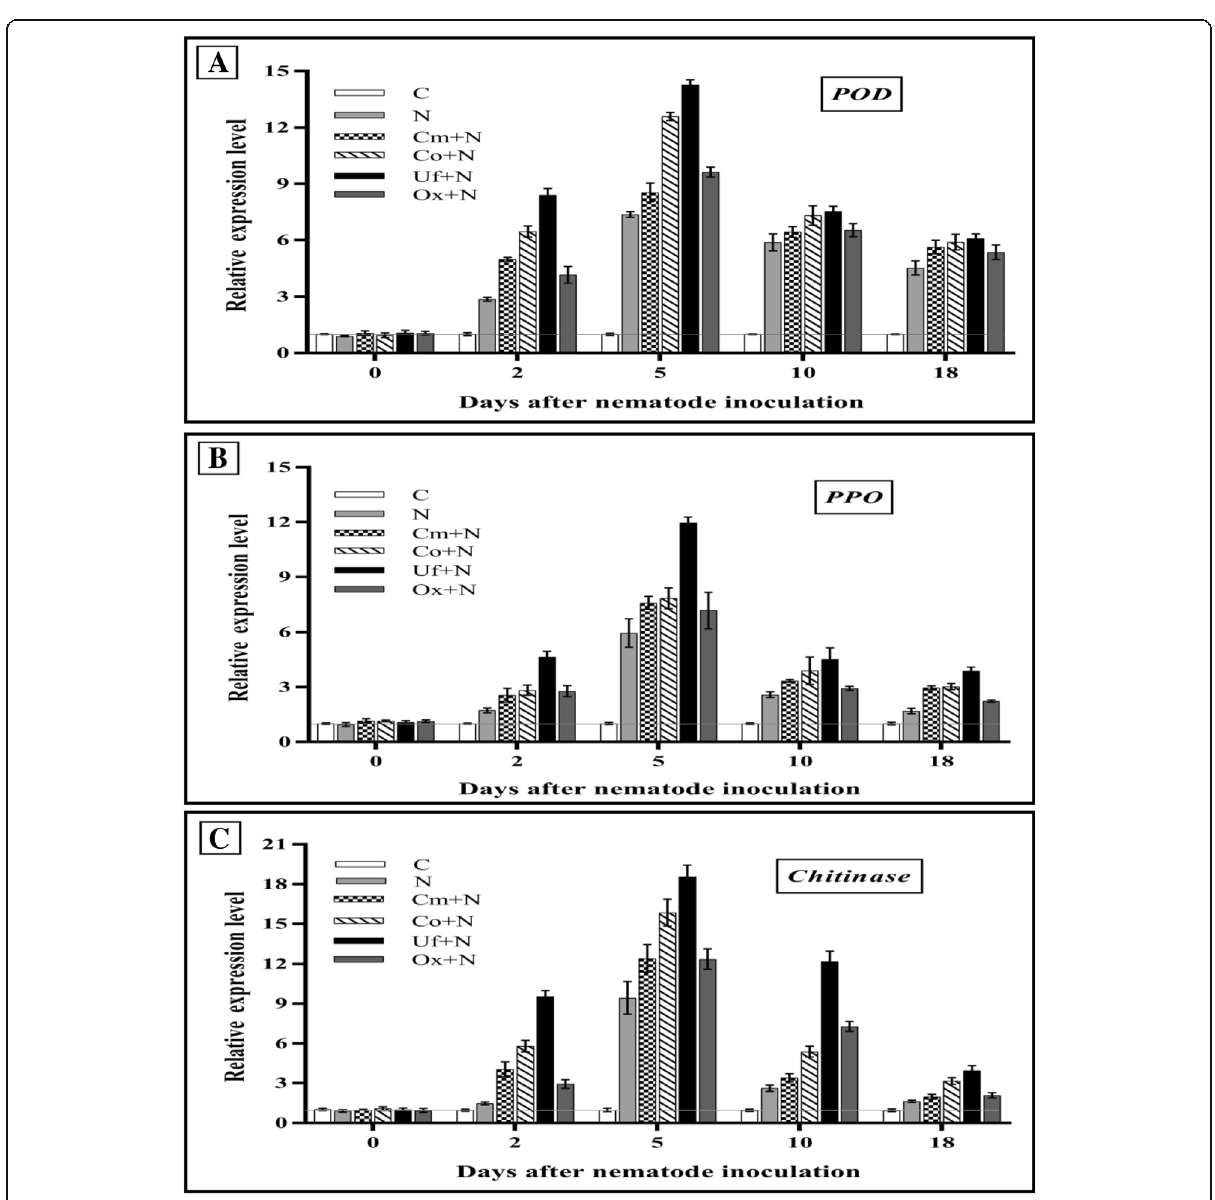
Fig. 3 POD ( a ), PPO ( b ), and chitinase ( c ) relative gene expression in roots of tomato plants inoculated with M . incognita (N) and treated with C . officinalis (Co + N), C . mediterranea (Cm + N), U . fasciata (Uf + N) extracts and the nematicide, oxamyl (Ox + N). Untreated un-inoculated plants served as control (C). The expression level of the target genes were normalized relative to 18S rRNA gene and relative expression of untreated control plants at each time were set as 1. Each value represents mean ± S.E ( n =